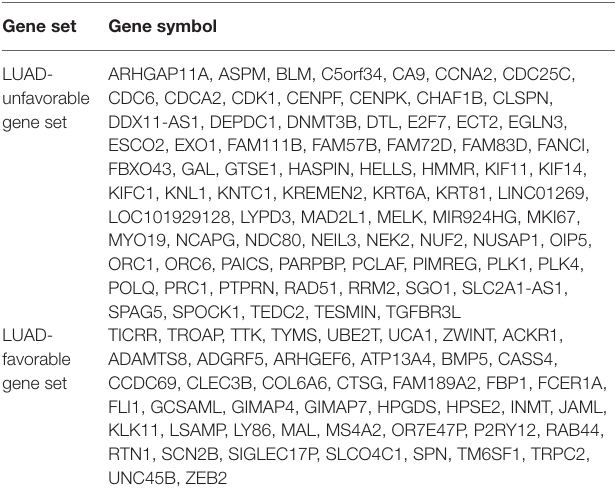
TABLE 1 | LUAD-unfavorable gene set and LUAD-favorable gene set.